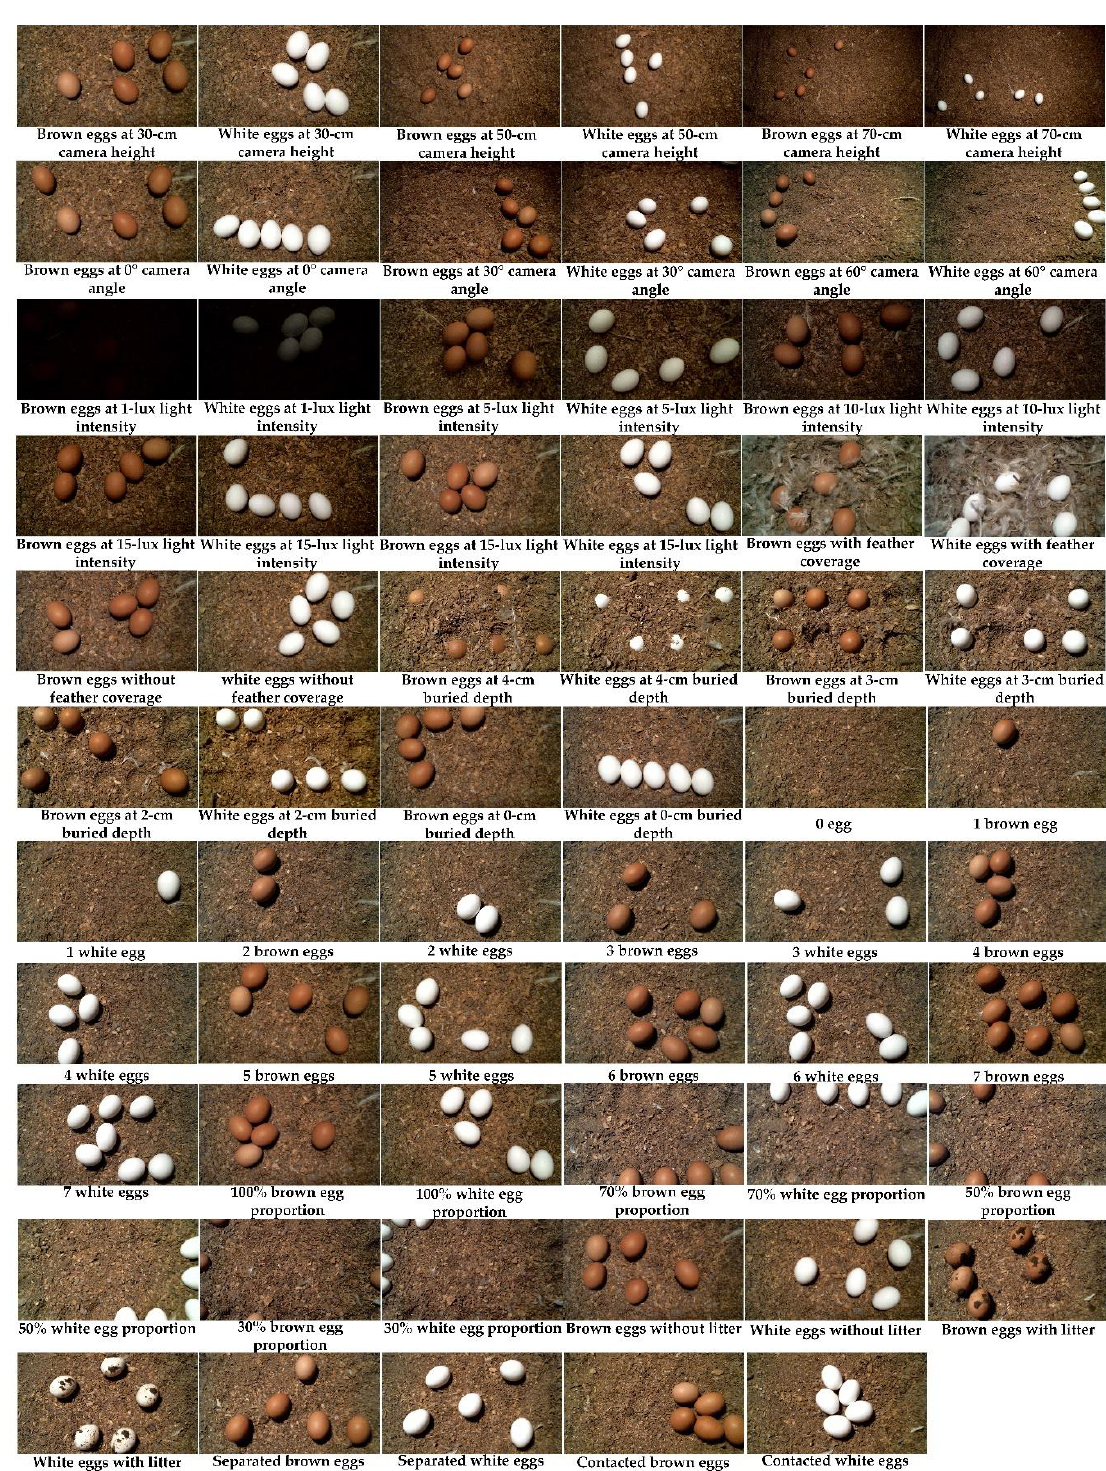
Figure 4. Sample images of floor eggs under various settings.